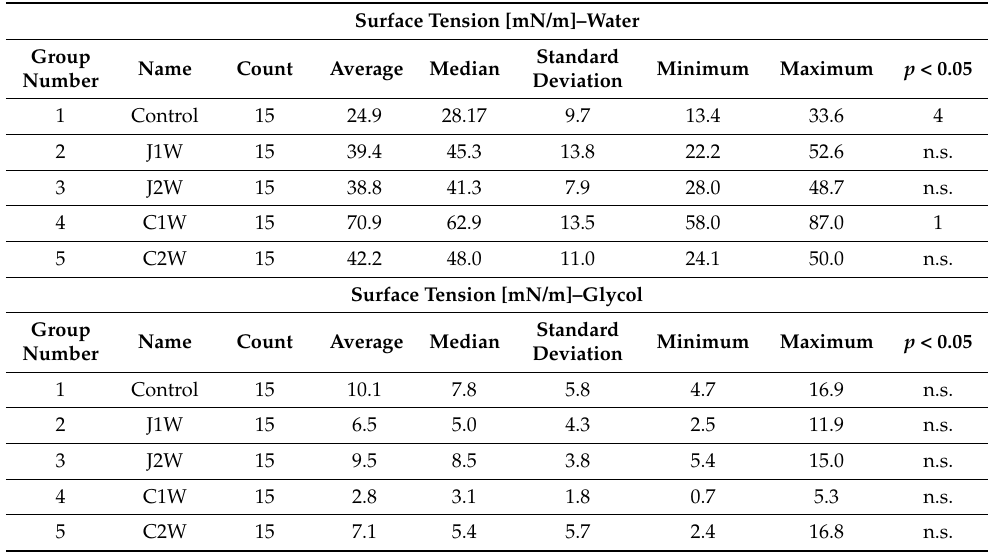
Table 6. Summary statistics of water and glycol surface tension, and results of Kruskal–Wallis multiple comparison test. (Control—control group, J1W—juice one week, J2W—juice two weeks, C1W—Coca- Cola one week, C2W—Coca-Cola two weeks, and n.s.—no statistically significant difference).